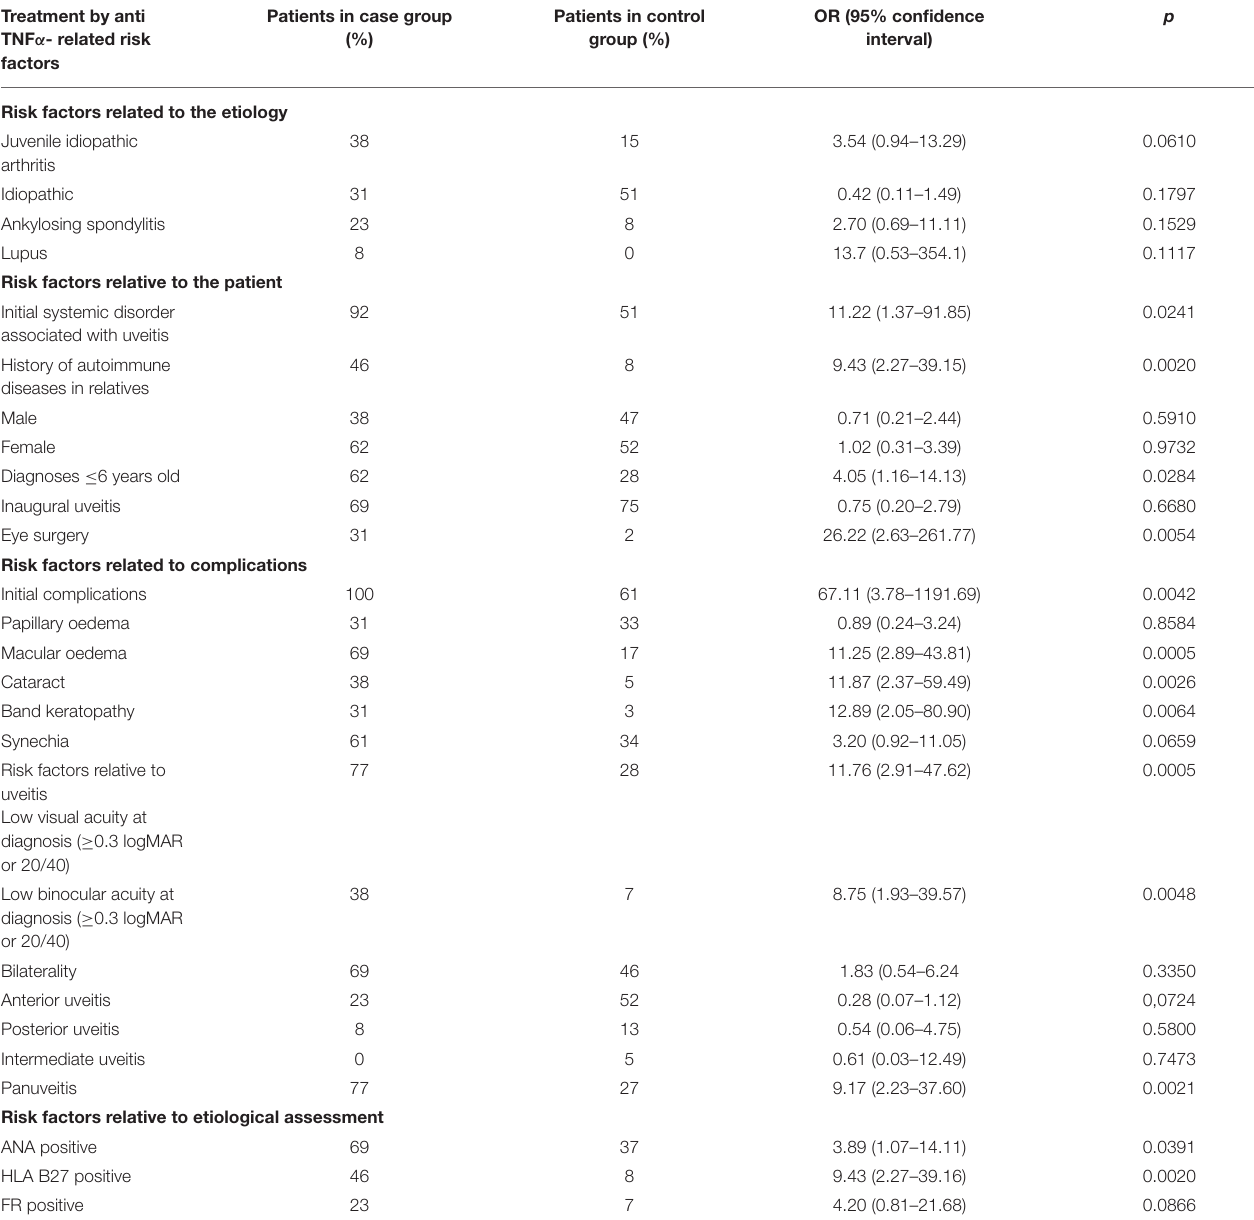
Patients in case group Patients in control OR (95% confidence (%) group (%)